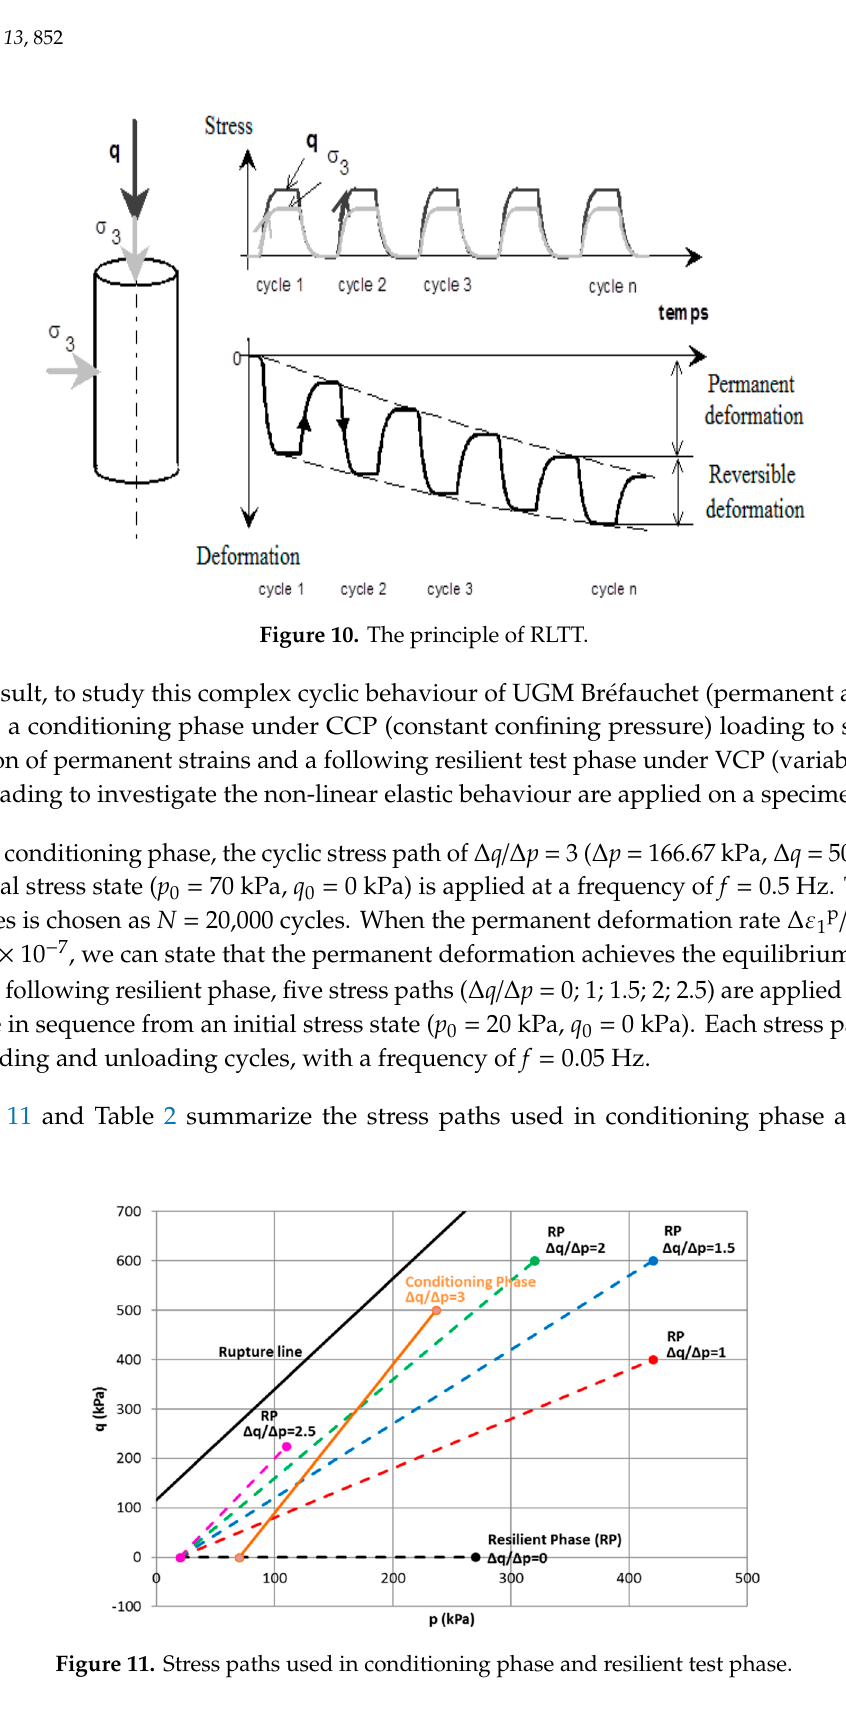
Figure 11. Stress paths used in conditioning phase and resilient test phase. Table 2. Stress paths used in conditioning phase and resilient test phase.